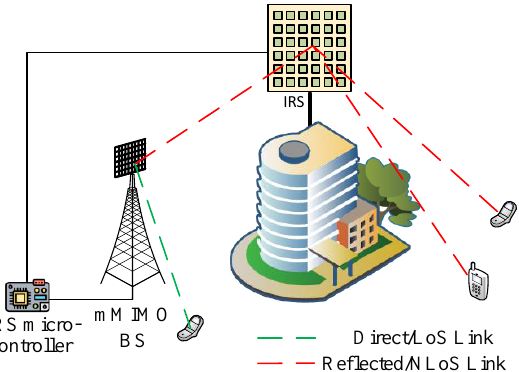
Figure 1. Implementation of an RIS-Assisted Wireless Communication System.